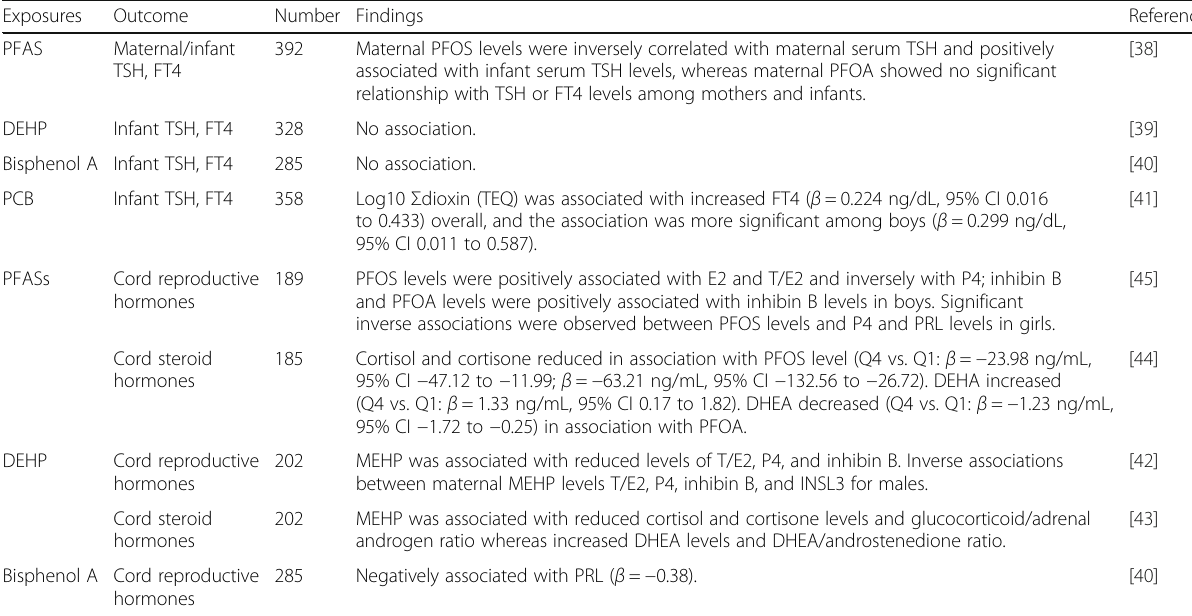
Table 8 Findings from the Sapporo cohort on the association between exposures and hormone levels at birth Exposures